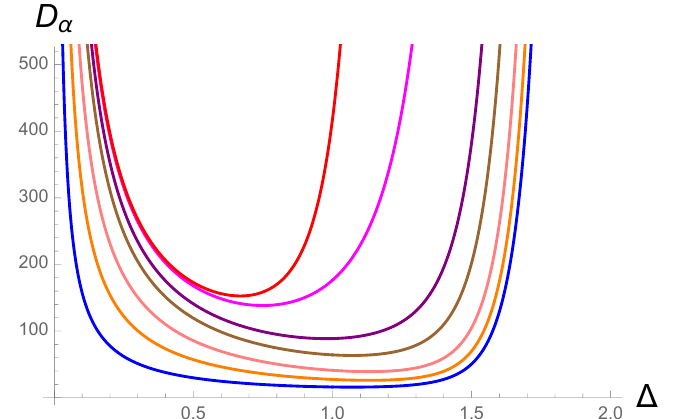
Figure 3 . Holographic R(cid:19)enyi divergence with (cid:21) = ~ (cid:21)= j (cid:1) (cid:0) 1 j and ~ (cid:21) (2 (cid:25)=(cid:12) ) (cid:1) (cid:0) 2 (cid:12)xed, for a cuto(cid:11) ~ (cid:15) = 0 : 0001 and inverse temperature (cid:12) = 2 (cid:25) . (cid:11) = 0 : 2 ; 0 : 4 ; 0 : 6 ; 0 : 8 ; 0 : 9 ; 0 : 99 ; 1 from the bottom up. We have rescaled the (cid:1)-independent prefactor ~ (cid:21) 2 c L 3 (cid:25) 2 2 5